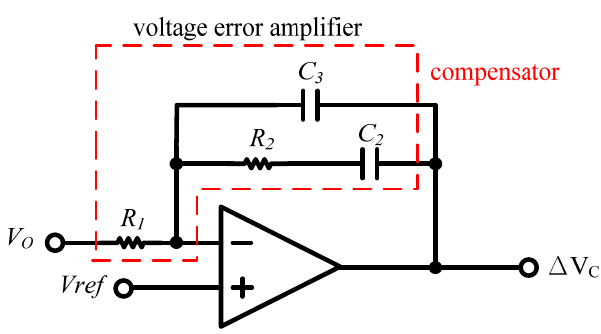
Figure 14. Schematic diagram of voltage error amplifier in PWM IC